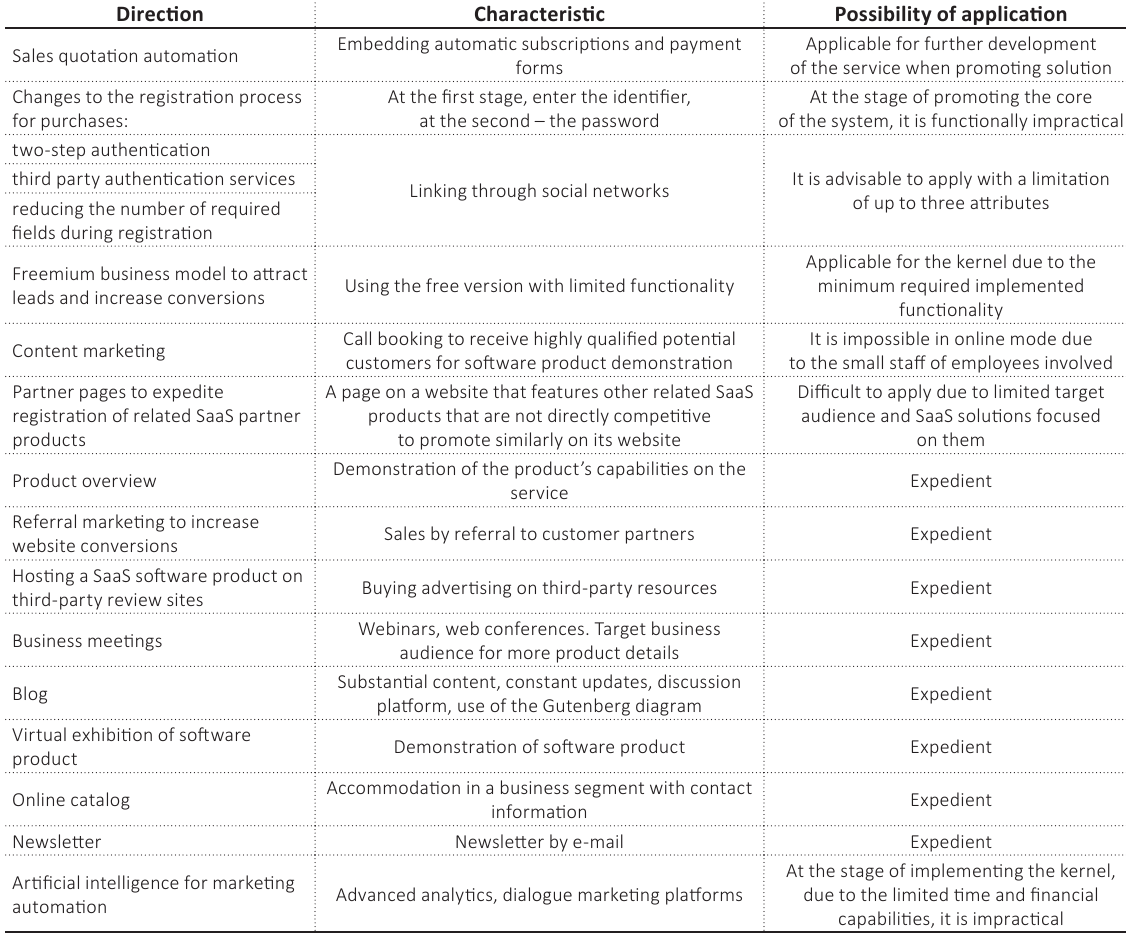
Table 4. Online marketing activities to promote the service Direction